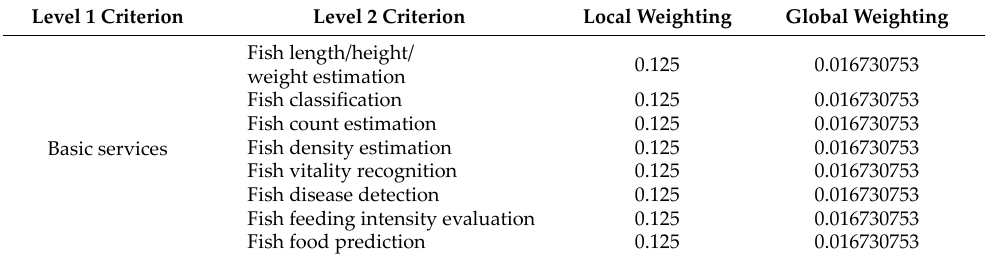
Table 10. Level 2 priority evaluation results for Level 1 basic services criterion using the modified AHP.